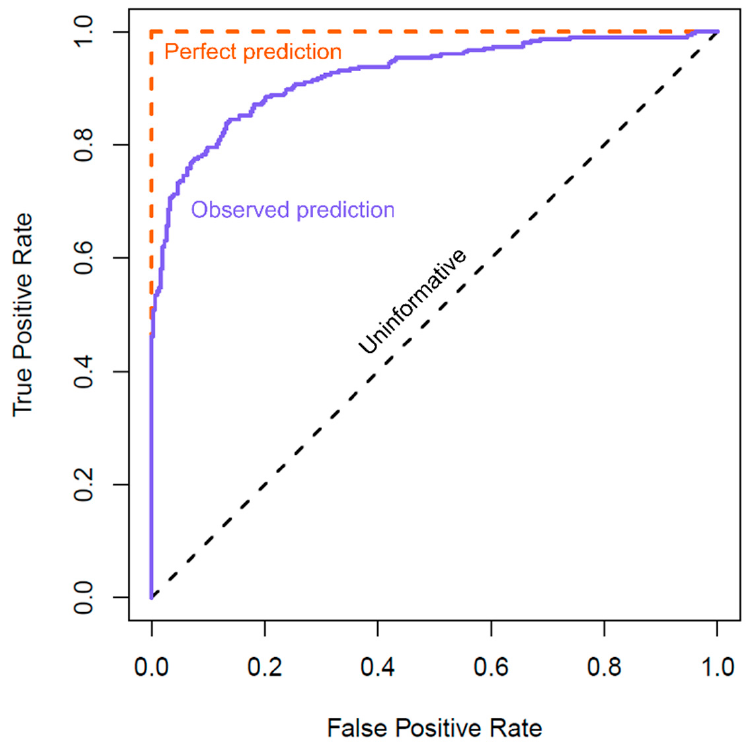
Figure 8. Receiver operating characteristic (ROC) curve showing the observed performance (com- pared to the uninformative case—random prediction—and a perfect estimation, where all observa- tions were correctly assigned to their true class.